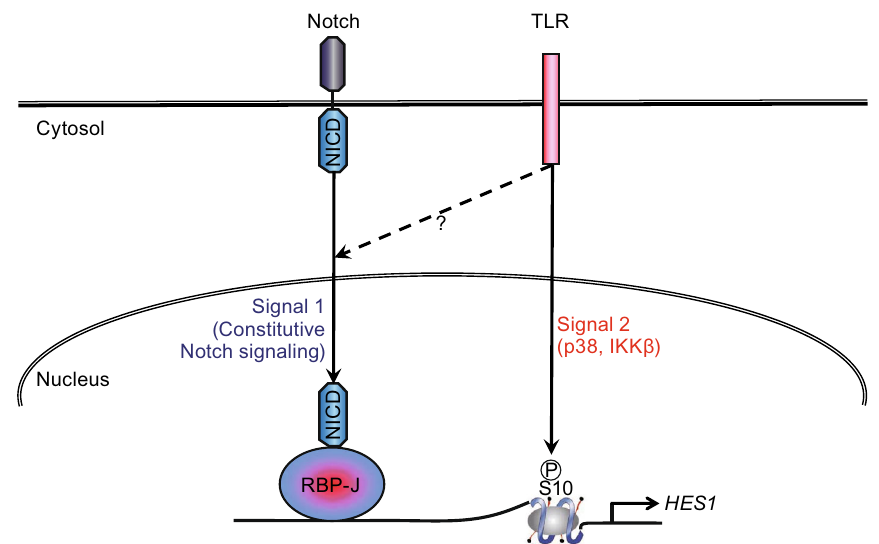
Figure 1. A model for activation of Notch target gene expression in human macrophages. Both signal 1 and signal 2 are required to achieve full- fl edged induction of Notch target genes by stimuli such as TLR ligands. Signal 1 is provided by constitutive tonic Notch signaling in macrophages presumably as a result of macrophage-macrophage or macrophage-stromal cell interaction. Signal 2 is provided by TLR stimulation in the form of p38-mediated phosphorylation of histones at the Notch target